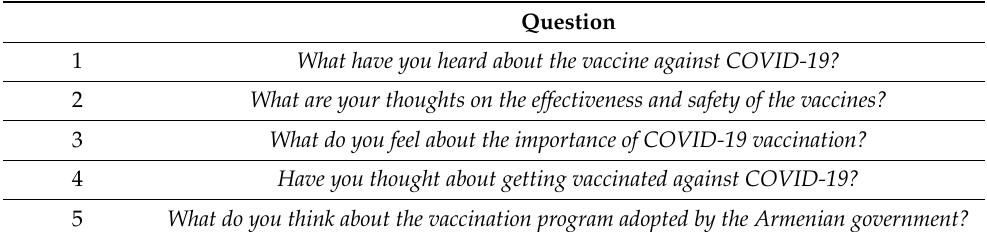
Table 1. Interview guide on attitude toward COVID-19 vaccination, readiness to get vaccinated, and vaccination